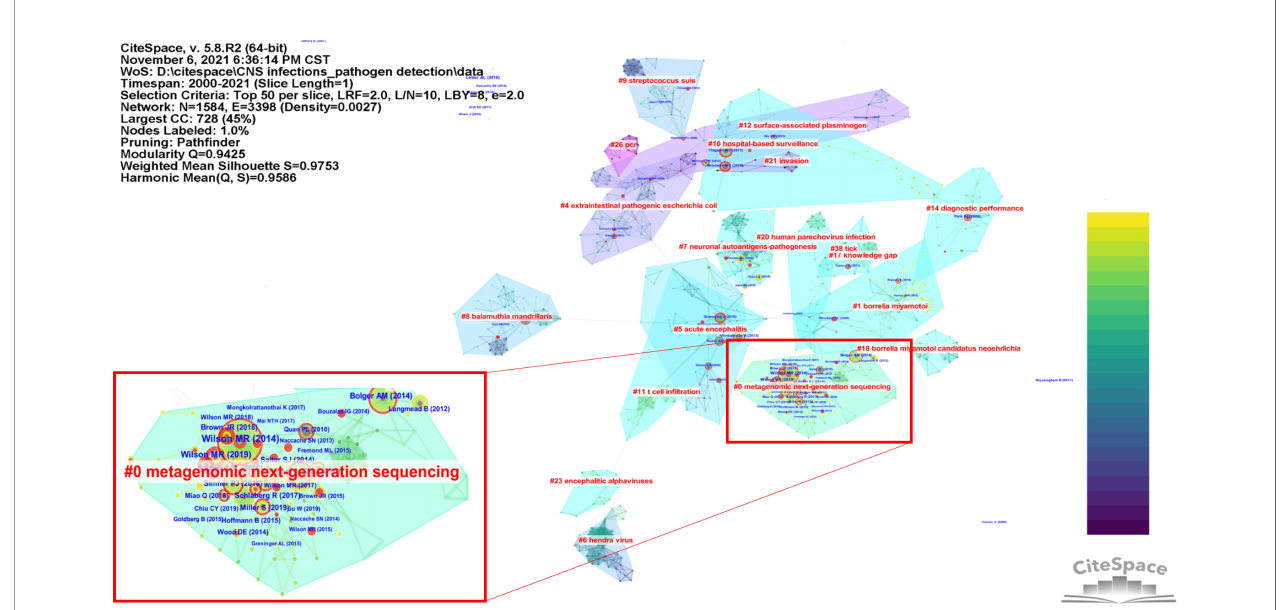
FIGURE 2 | An overview of a network of co-cited references on pathogen detection in CNS